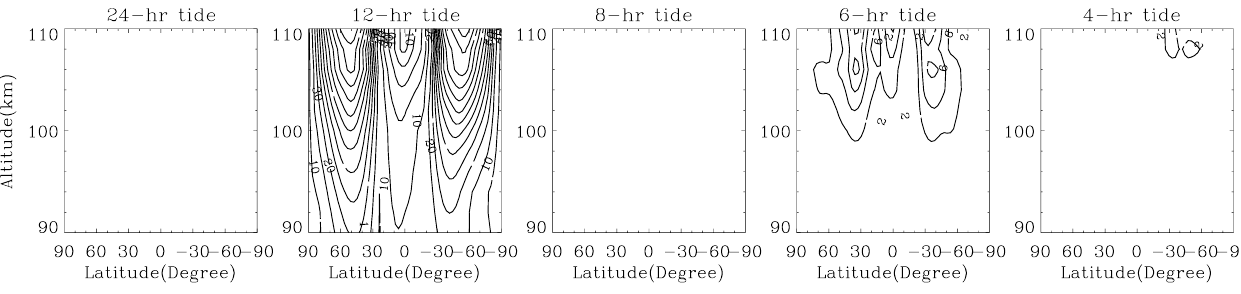
Fig. 11. Five tidal component amplitudes in the zonal wind for March. For the 12-h tide the minimum value of the contour is 1ms − 1 , and the intervals of the contours are 5ms − 1 when the amplitudes are greater than 5ms − 1 . For the other components, the minimum values and intervals of the contours are 2ms − 1